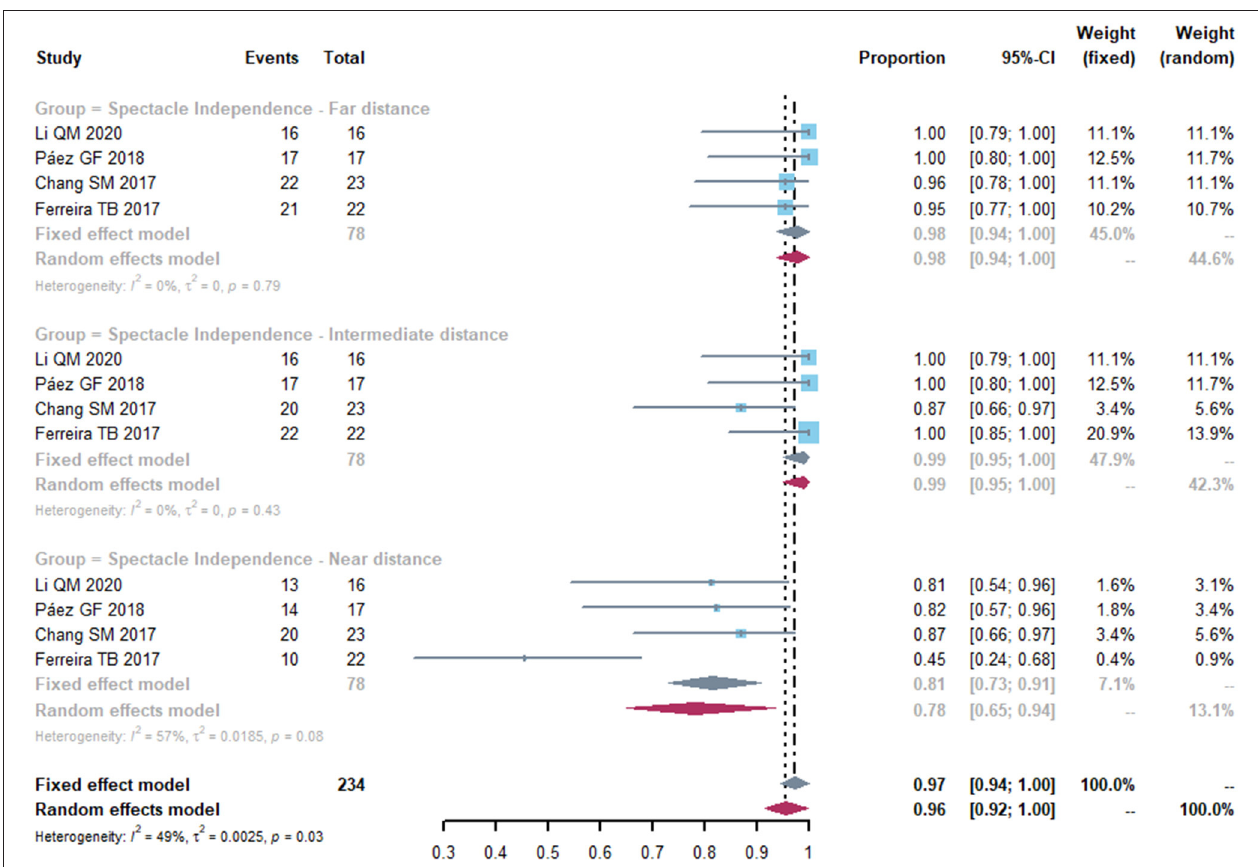
FIGURE 5 | Forest plot of spectacle independence of far, intermediate and near distance. Total, total number of treated eyes. Proportion, proportion of eyes achieved spectacle independence at far, intermediate and near